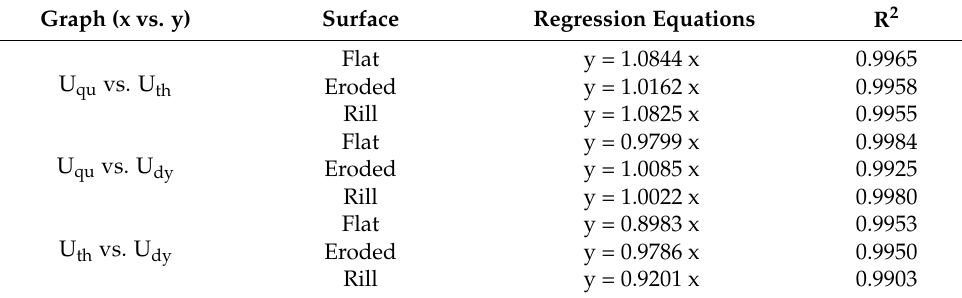
Table 4. The regression equations and coefficient of determination (R 2 ) of graphs in Figure